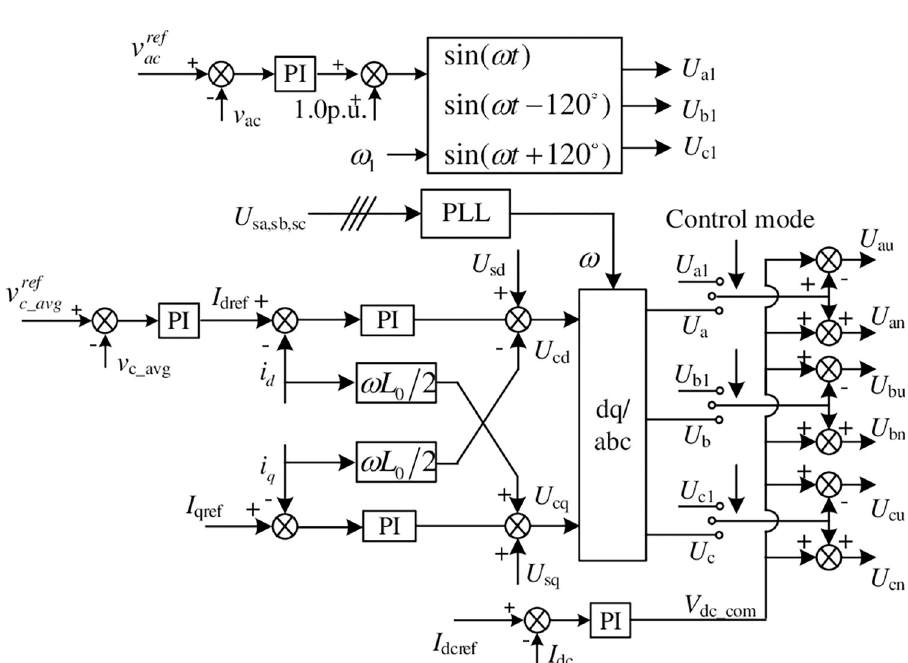
Fig 2. Double-closed loop control structure of hybrid MMC topology.